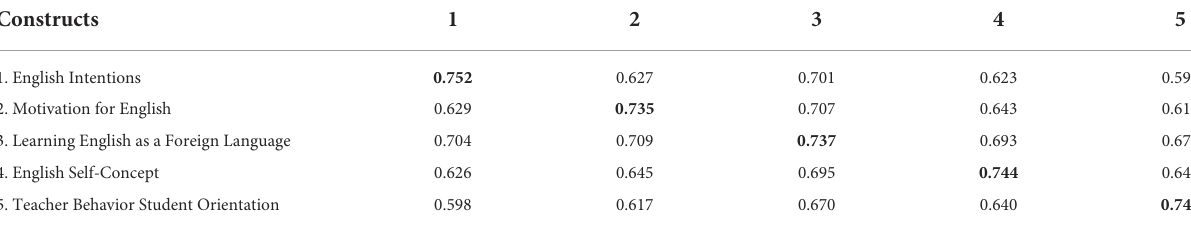
TABLE 3 Discriminant validity analysis (Fornel Larcker and